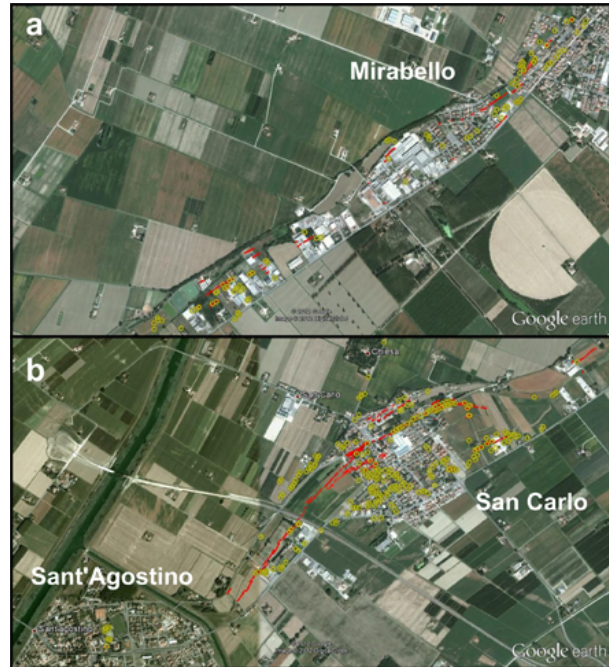
Fig. 2. Maps showing the liquefaction sites (yellow circles) and sur- face cracks (solid red lines) in the area of Mirabello (a) and San Carlo with Sant’Agostino (b)